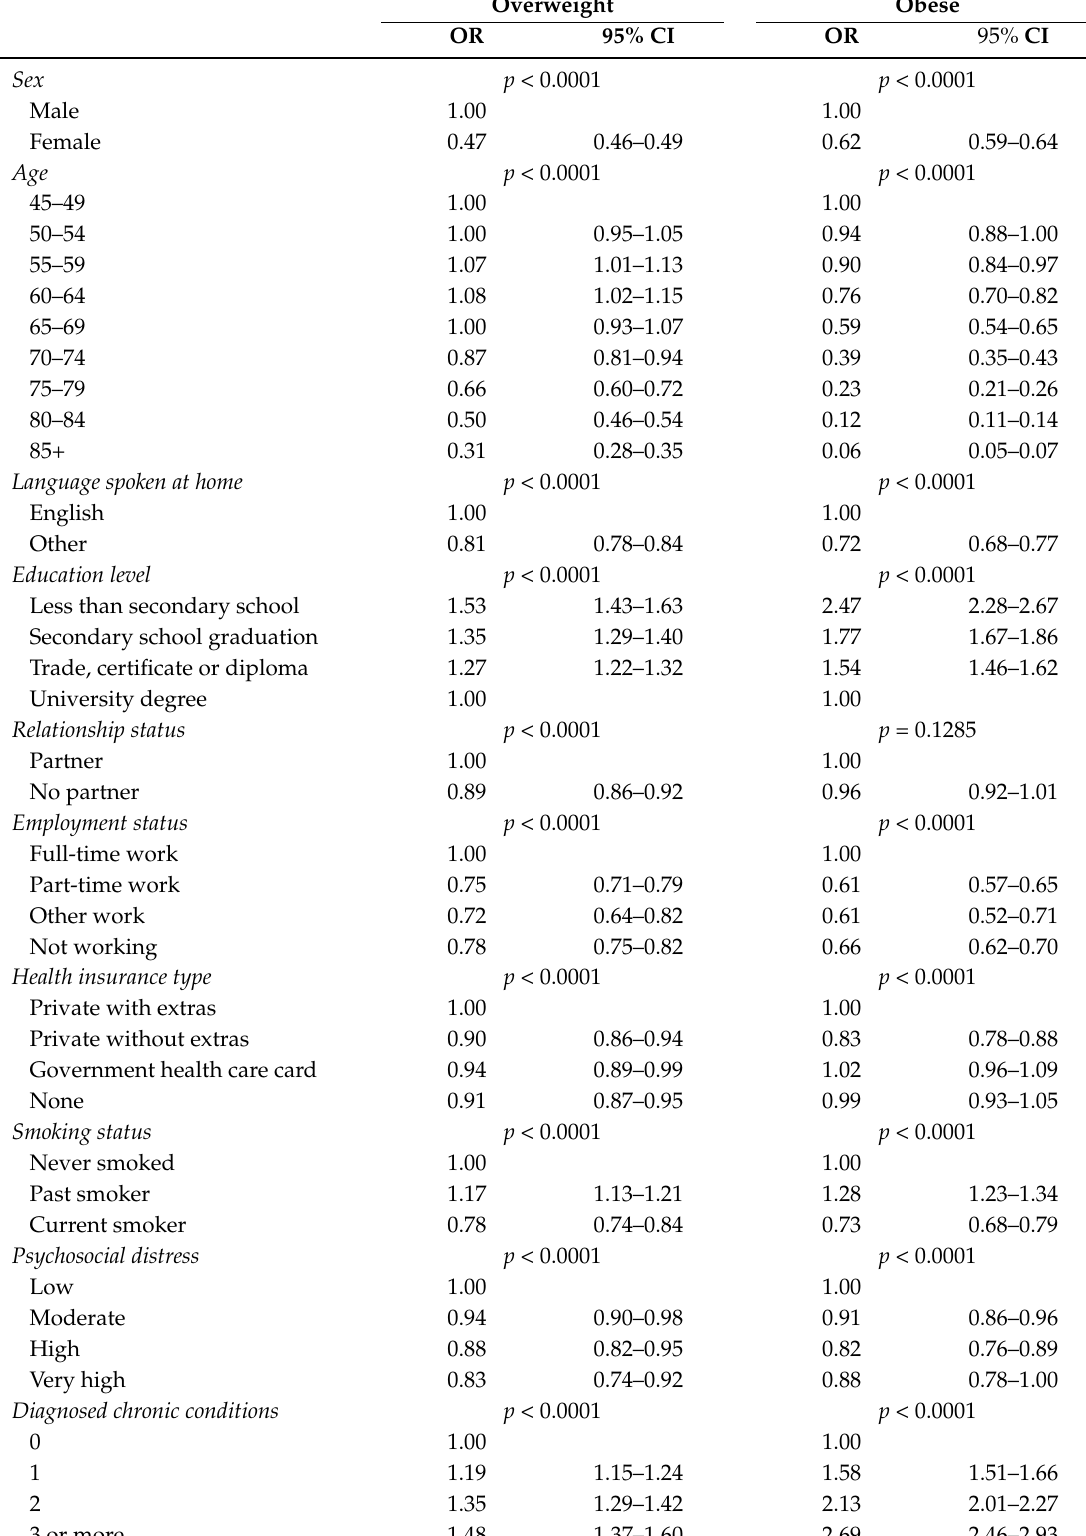
Table 2. Adjusted odds ratios for individual-level analyses of overweight and obesity.